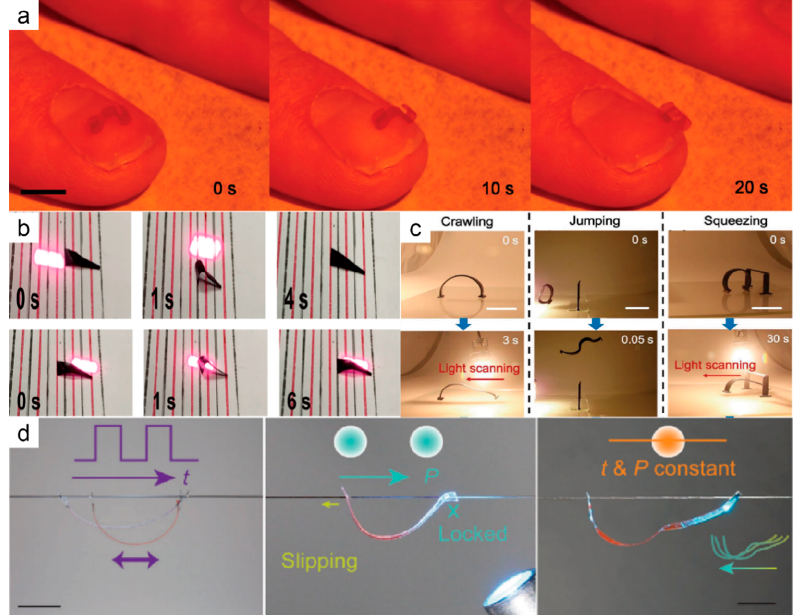
Figure 10. ( a ) Caterpillar robot crawling on a human fingernail under the irradiation of a 488 nm laser (Reprinted with permission from Ref. [87]. Copyright 2018, John Wiley and Sons). ( b ) Image of a trapezoidal LCE robot crawling forward and backward under near-infrared light (Reprinted with permission from Ref. [93]. Copyright 2022, American Chemical Society). ( c ) Multimodal locomotion of a soft robot powered by light (Reprinted with permission from Ref. [27]. Copyright 2019, John Wiley and Sons); ( d ) A robot moves along a hair in different patterns. One is friction control, which uses light to lock and slide between the legs and the other is a self-oscillating mode (Reprinted with permission from Ref. [89]. Copyright 2022, John Wiley and Sons).